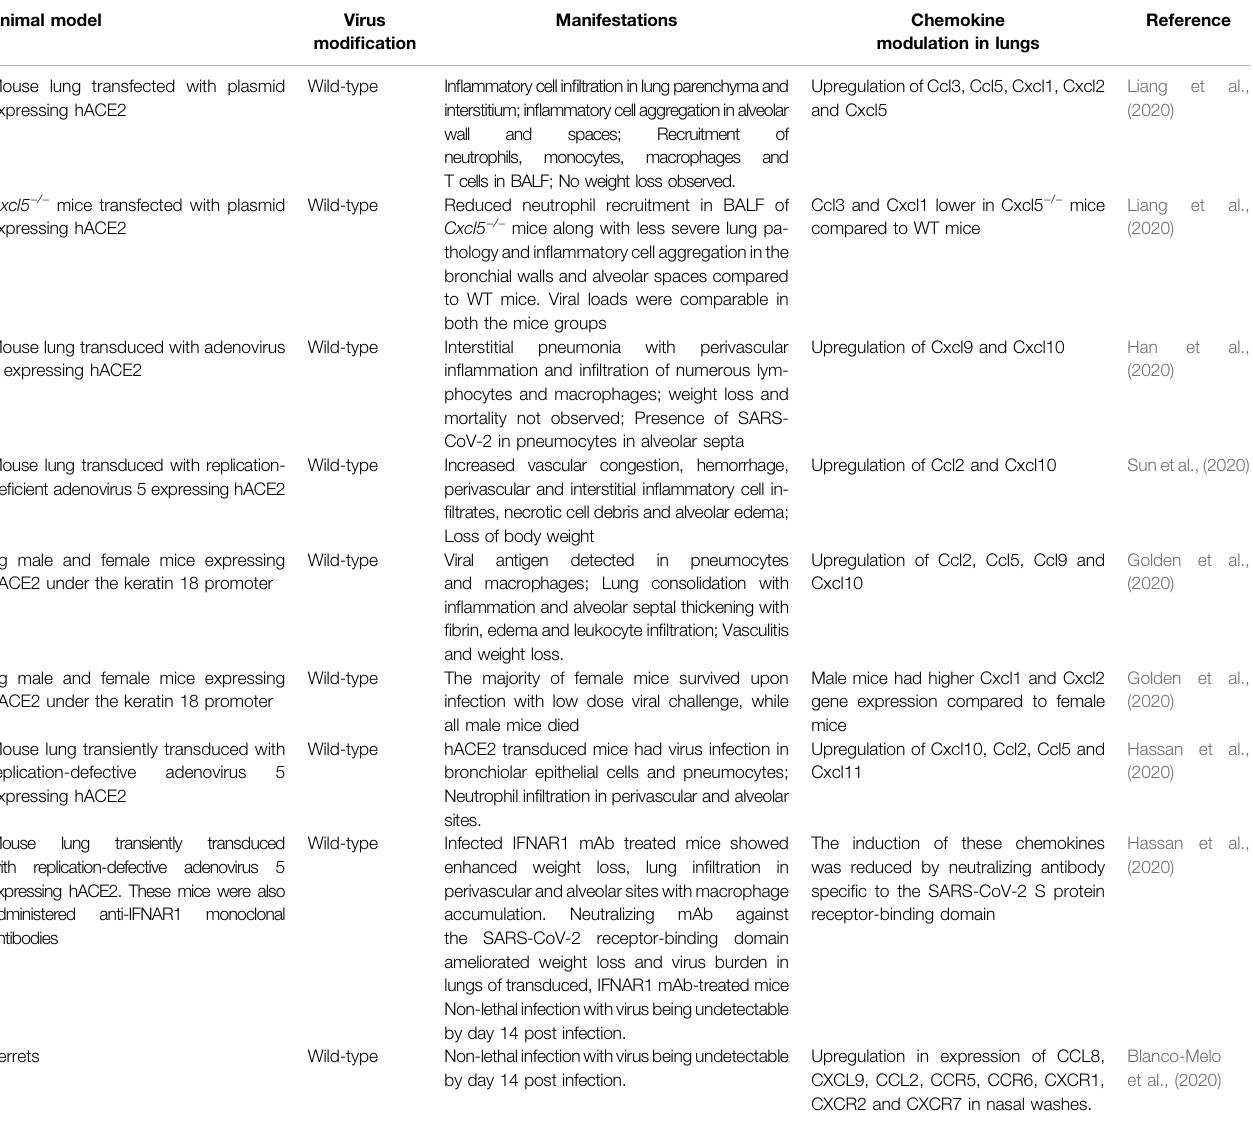
Table 4 | Chemokine regulation in the lungs of animal models of SARS-CoV-2-induced viral